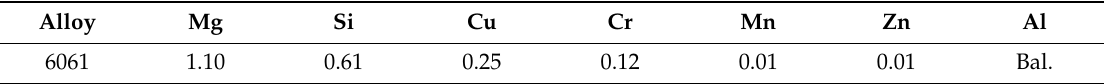
Table 1. Chemical composition of 6061 aluminum alloy (wt.%).